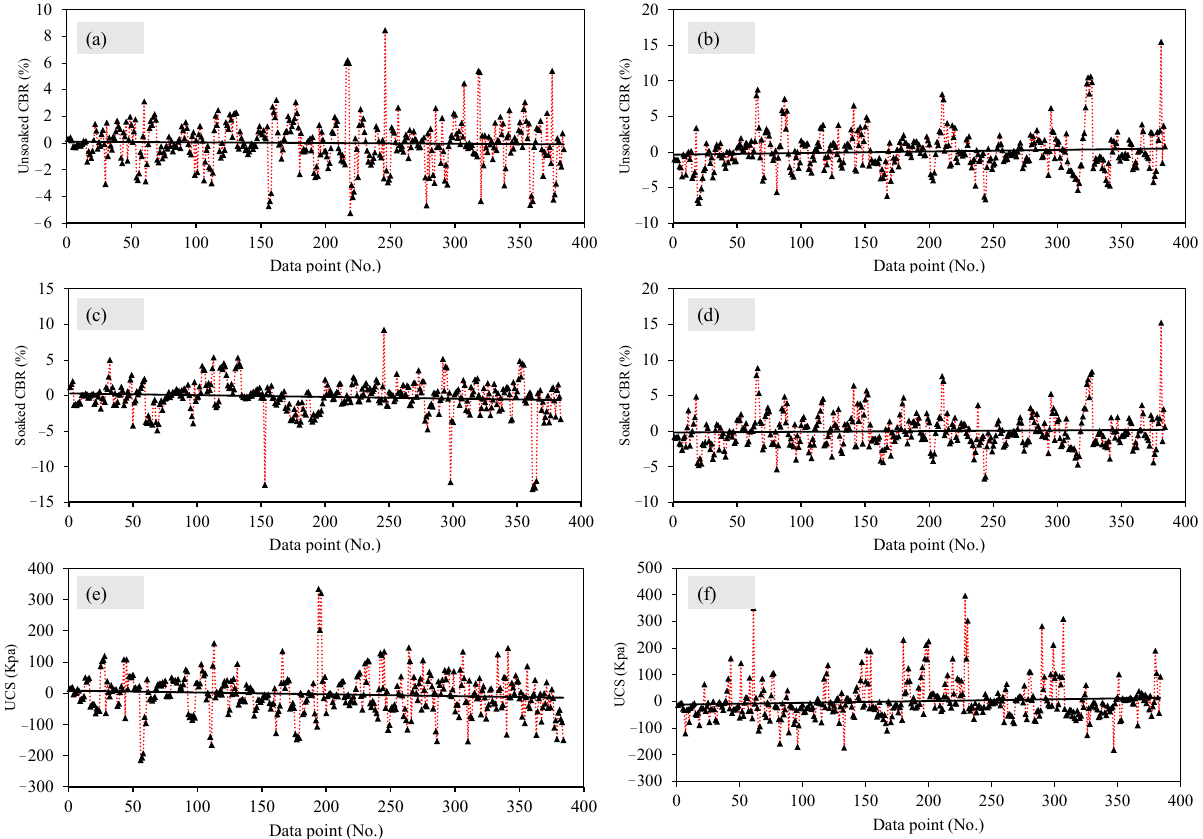
Figure 8. Residual errors plotted between experimental and predicted results in the case of: ( a , c , e ) ANN model, ( b , d , f ) and RF Model.